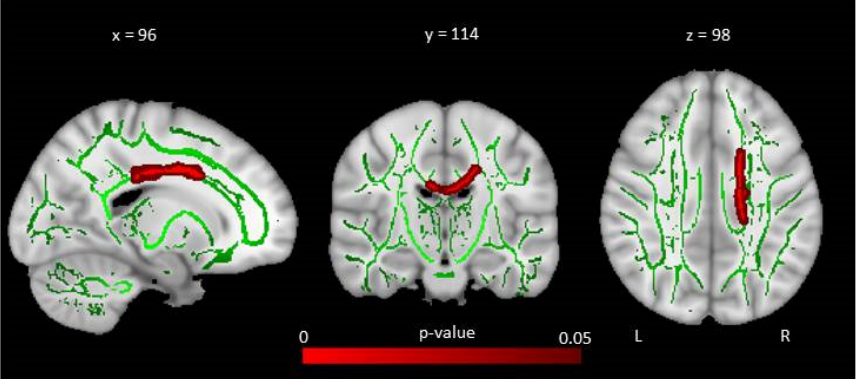
Figure 3. Results from tract-based spatial statistics analyses: voxelwise group differences in fractional anisotropy when comparing cystinosis patients and healthy controls. Sagittal, coronal, and axial slices of the tract-based spatial statistics contrasts between cystinosis patients and healthy controls. Red clusters indicate reduced fractional anisotropy in cystinosis patients compared to healthy individuals. Images of contrast are overlaid on a standard Montreal Neurological Institute (MNI) template 1 mm brain and a fractional anisotropy skeleton (in green) with a threshold set to range from 0.2 to 0.8. Tract-based spatial statistics results are thresholded at p ≤ 0.05, corrected for multiple comparisons across space (FWE) using threshold-free cluster enhancement adjusted for age and sex.